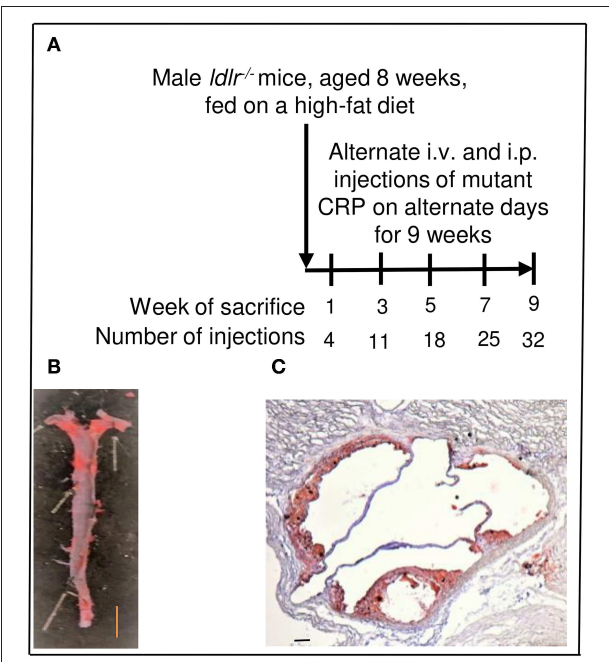
FIGURE 1 | Assessment of atherosclerotic lesions in ldlr − / − mice. (A) Protocol for administration of mutant CRP and for sacrifice of mice after mutant CRP administration. (B) Quantitation of atherosclerotic lesions in the aorta ( en face ). A representative Sudan IV-stained aorta is shown. The red colored areas are the lesions. Scale bar, 5mm. (C) Quantitation of atherosclerotic lesions in the aortic root. A representative Oil Red O-stained aortic root section is shown. The red colored areas are the lesions. Scale bar, 100 µ